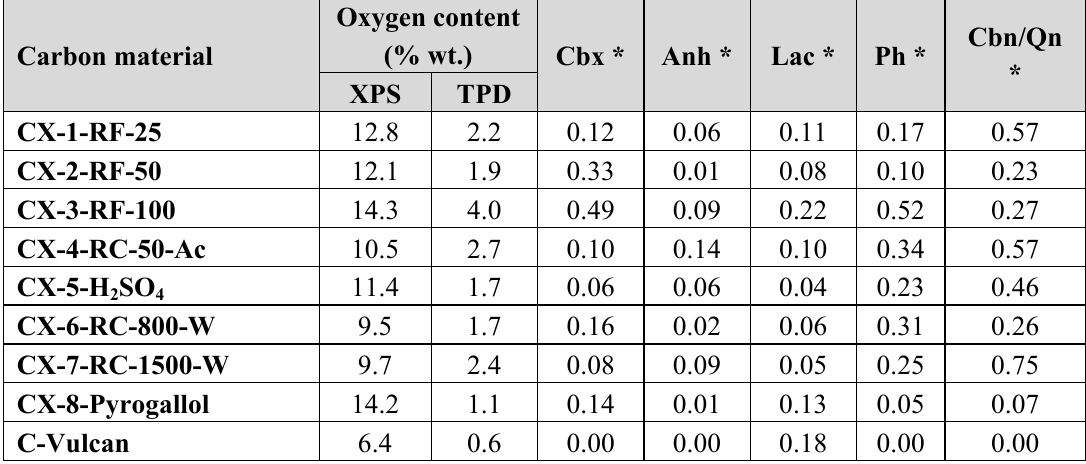
Table 2. Oxygen content from XPS and TPD, as well as surface oxygen groups composition obtained from the deconvolution of the CO and CO carbon supports. Carbon